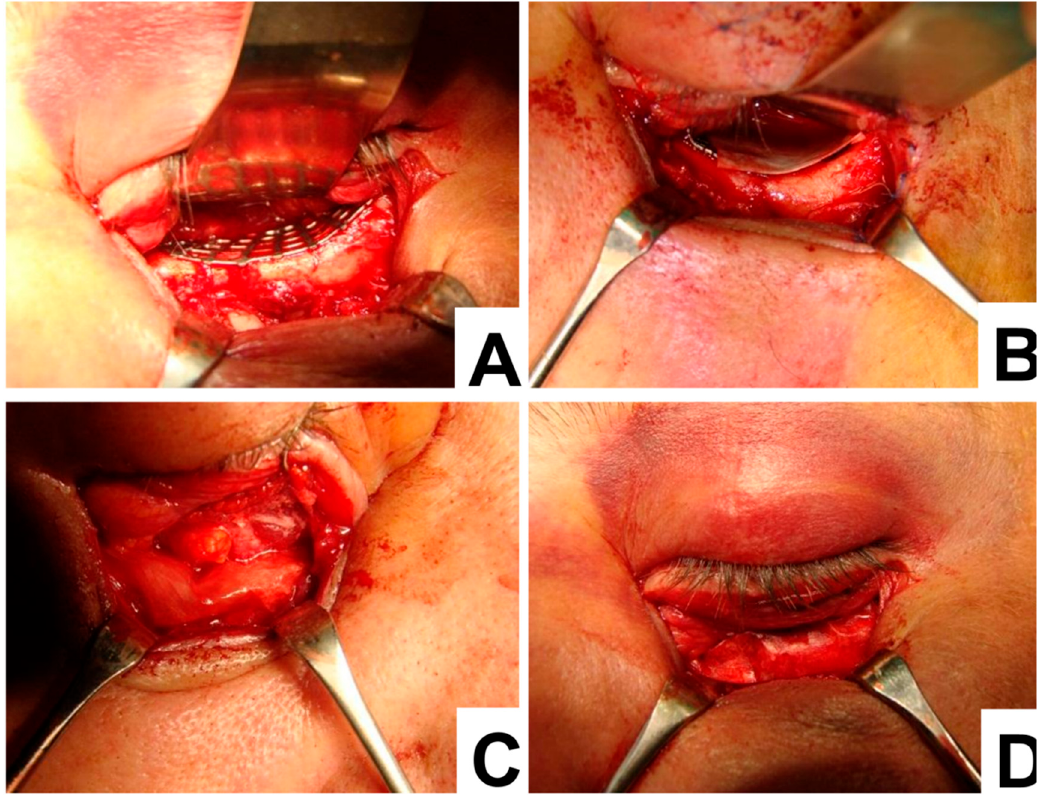
Figure 2. Surgical technique. ( A ) Titanium mesh set parallel to the orbital frame; ( B ) collagen membrane set parallel to the titanium mesh edge; ( C ) prolapsed orbital fat and collagen membrane and ( D ) titanium mesh, fully covered with collagen membrane.